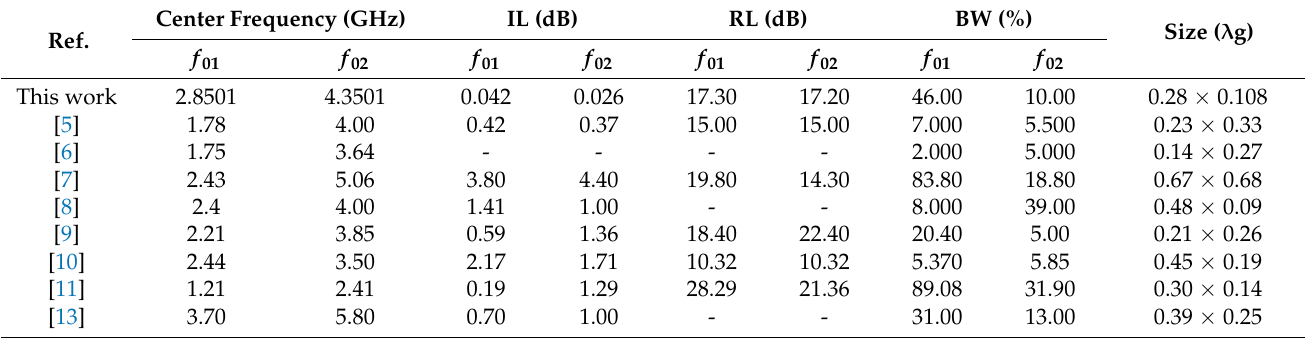
Table 2. Characteristics of proposed BPF and similar